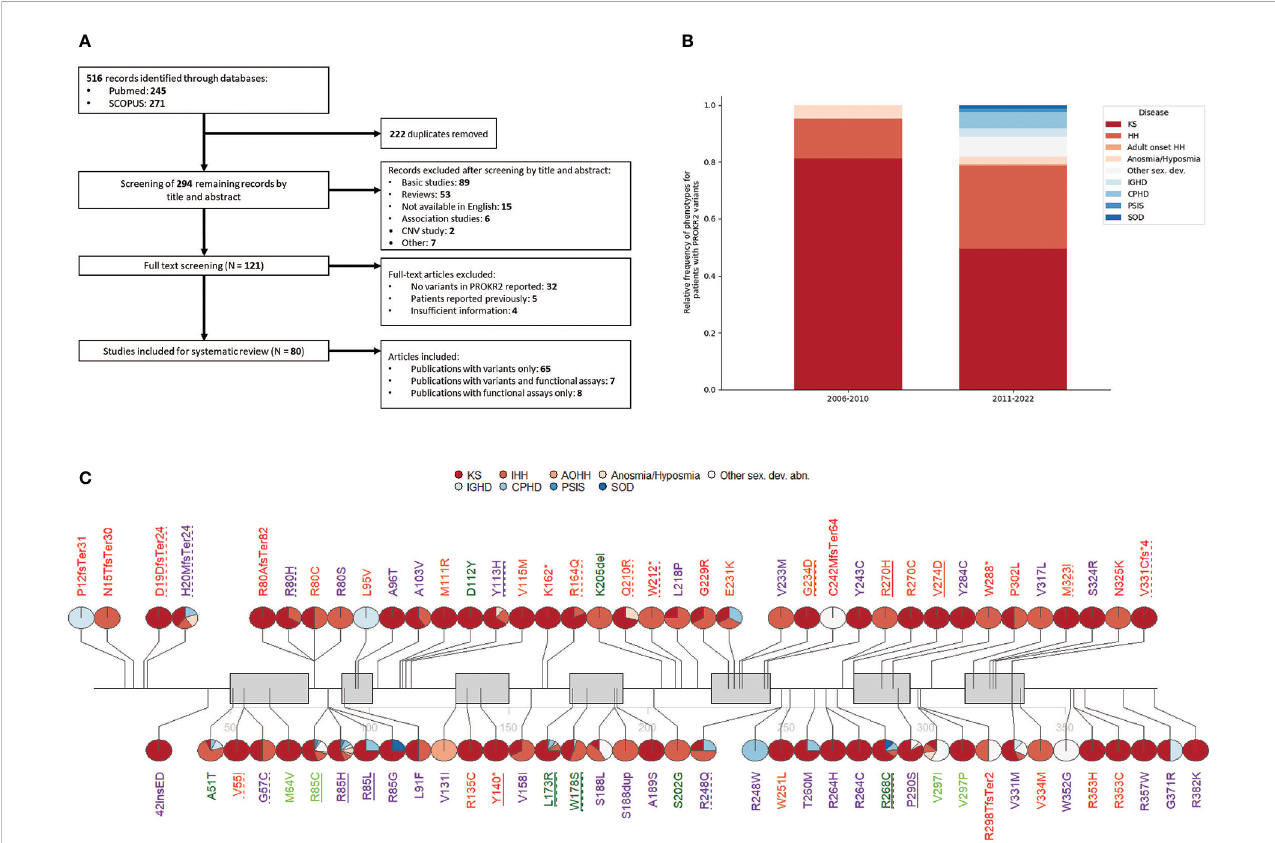
FIGURE 1 (A) Flow diagram showing the search and selection of studies. (B) Relative frequency of phenotypes in patients harboring PROKR2 pathogenic or likely pathogenic variants. (C) Reported PROKR2 variants. Pie charts next to each variant denote the percentage of patients carrying that variant that presented each phenotype. Each variant is coloured according to ACMG classi fi cation, where P = red, LP = orange, VUS = purple, LB = light green, B = dark green. Dotted underline means the variant was reported at least once as compound heterozygous and a full underline that it was reported at least once as homozygous. Gray boxes indicate transmembrane